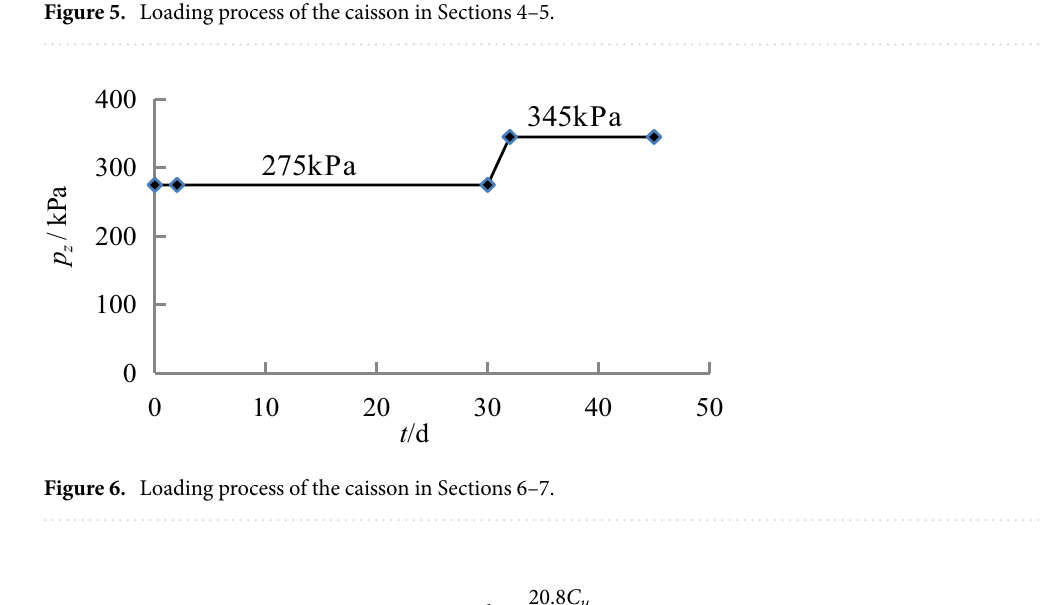
Figure 5. Loading process of the caisson in Sections 4–5.